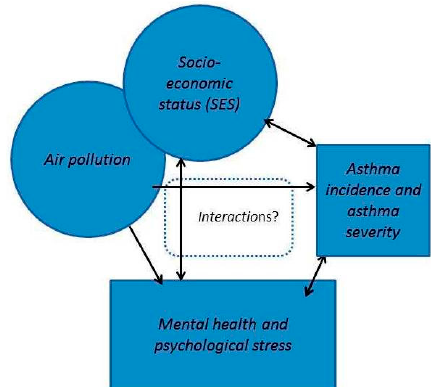
Figure 1. Possible causal pathways between exposure to air pollution, mental health, socioeconomic status and asthma.